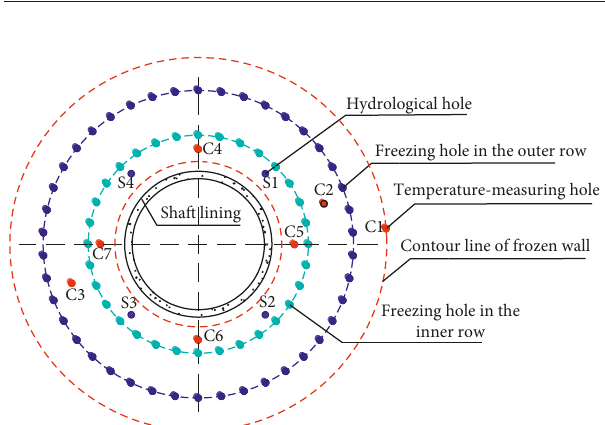
Figure 2: Schematic diagram of the distribution of the freezing pipes.